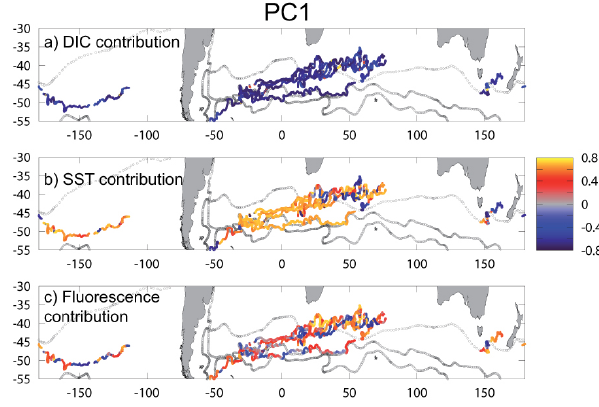
Fig. 12. PC1 loadings for DIC, SST and fluorescence. Note that principal component loadings are correlation coefficient between -1 and